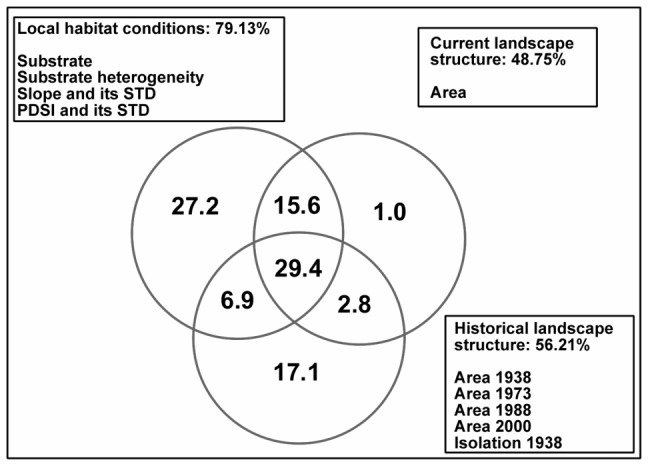
Variation explained by the local habitat condition, current landscape structure and historical landscape structure.For each group of factors, the significant predictors are ranked from the predictor with the highest explanatory power.